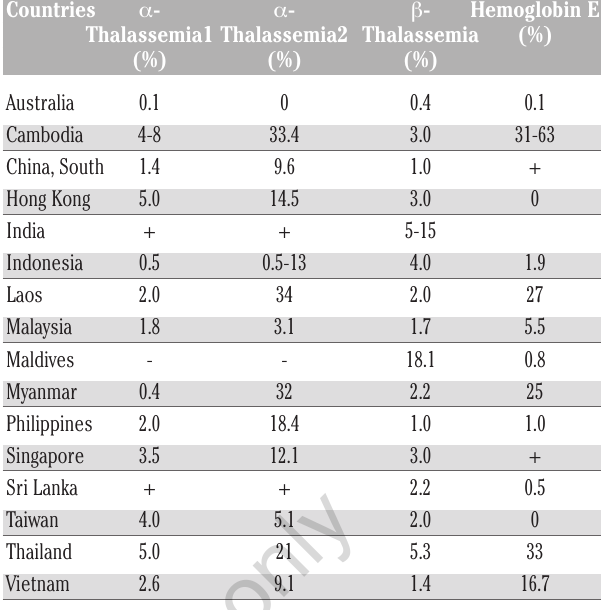
Table 1. Prevalence of thalassaemia in Asia and